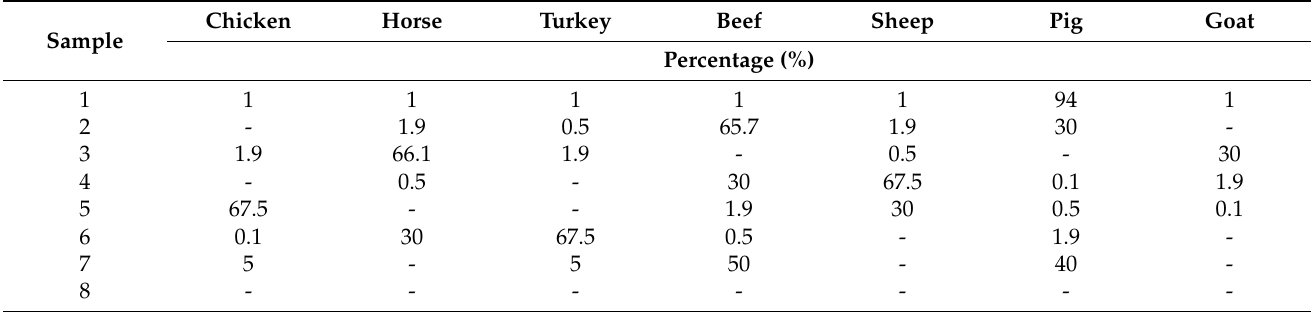
Table 1. Sample composition. Samples 1–6: DNA extract mixtures; percentage refers to DNA ( v / v ). Sample 7: extract from a model sausage; percentage refers to meat content ( w / w ). Sample 8: DNA extract from maize (negative control). - indicates that the species is not in the DNA extract mix-